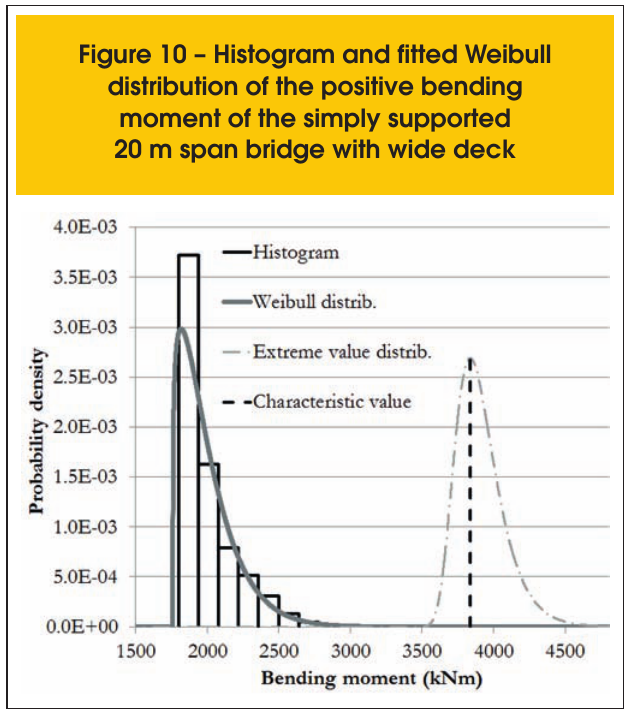
Figure 10 – Histogram and fitted